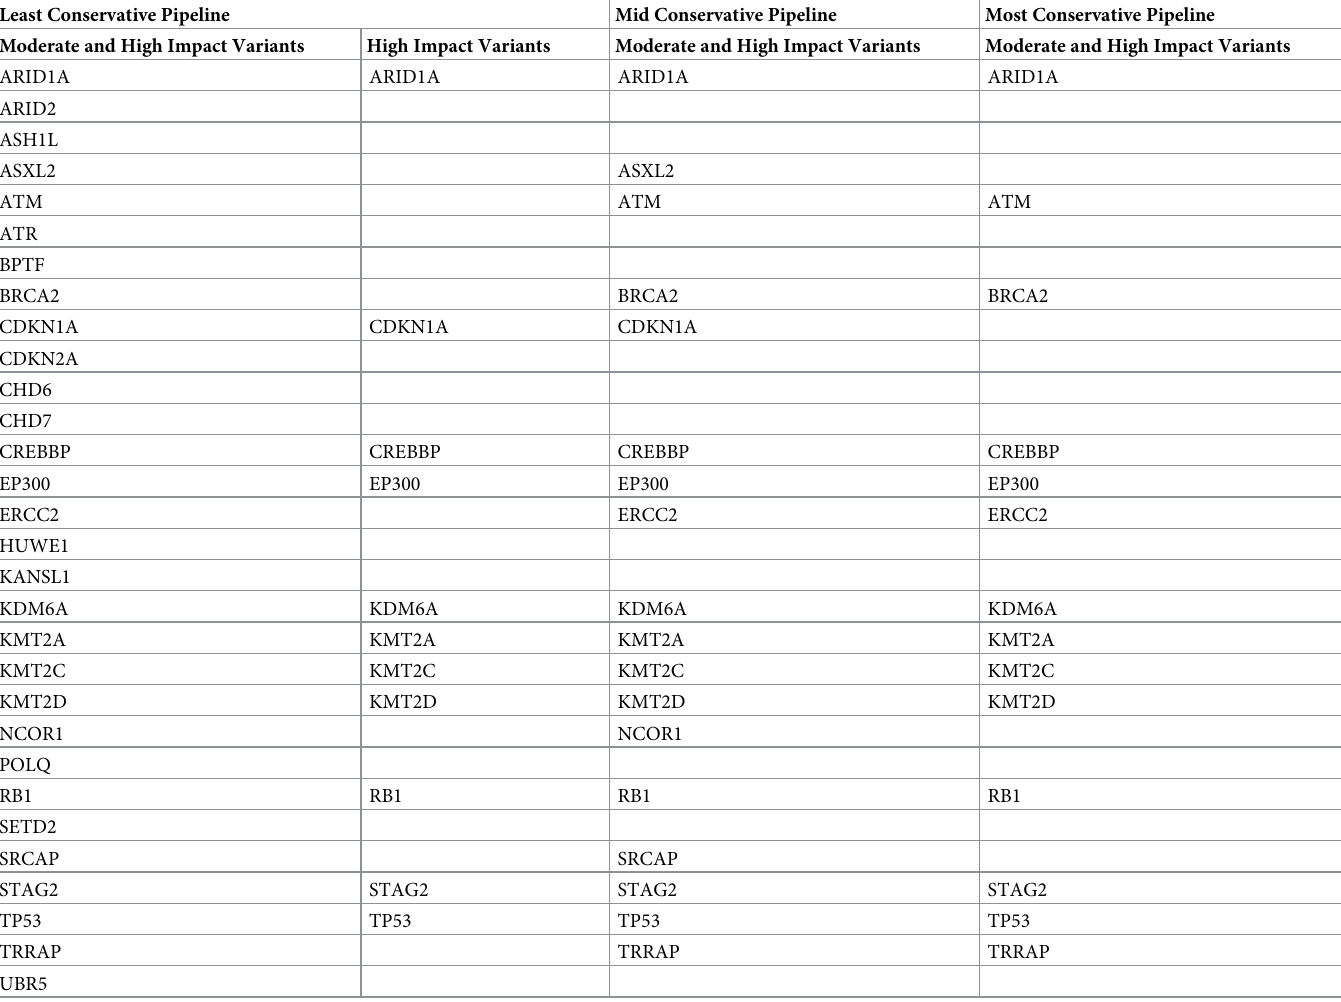
Table 1. Summary of genes found in each of the data subsets.